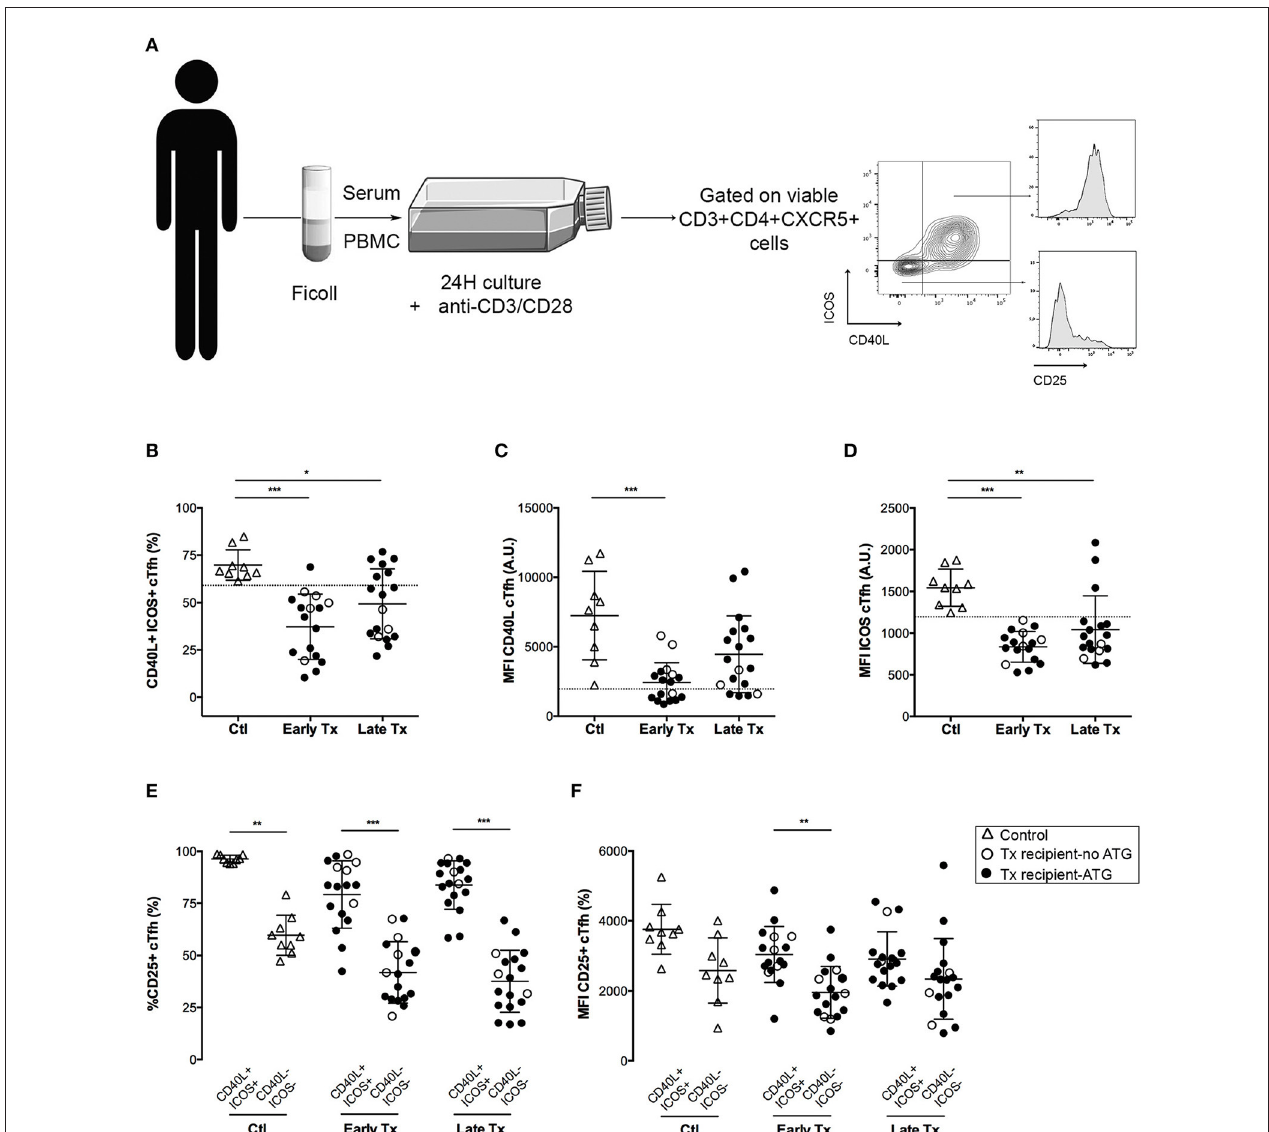
FIGURE 2 | Comparison of the functional profile of cTfh of controls and transplants patients. (A) Graphical summary of the procedure used to evaluate the functionality of cTfh. PBMC of patients were collected just before vaccination. The level of expression of CD40L ICOS and CD25 was measured by flow cytometry on the surface of cTfh, after 24h stimulation with anti-CD3/CD28 microbeads in patient’s own serum. (B) The percentage of CD40L + ICOS + cTfh was enumerated by flow cytometry after 24h of in vitro stimulation in healthy volunteers ( n = 9; controls, Ctl; open triangles), and transplant patients ( n = 36, circles). The nature of induction immunosuppressive therapy received by transplant patient is indicated. Transplant patients were distributed into two groups according to the time elapsed since transplantation: (i) 6–12 months: early post-transplantation (Early Tx; n = 18), and (ii) > 12–72 months: late post-transplantation (Late Tx; n = 18). Dotted line indicates the lower value observed in control patients. (C,D) The level of expression of CD40L (C) and ICOS (D) , as reflected by mean fluorescence intensity (MFI), was measured by flow cytometry after 24h of in vitro stimulation of cTfh and compared between the 3 groups. (E) The percentage of CD25-positive cells was compared between CD40L + ICOS + and CD40L − ICOS − cTfh subsets in the 3 groups. (F) The level of expression of CD25 was compared between CD40L + ICOS + and CD40L − ICOS − cTfh subsets in the three groups. Each symbol represents a patient, mean ± SD is indicated. * p < 0.05; ** p < 0.01; *** p < 0.001; ANOVA, Dunn’s multiple comparisons